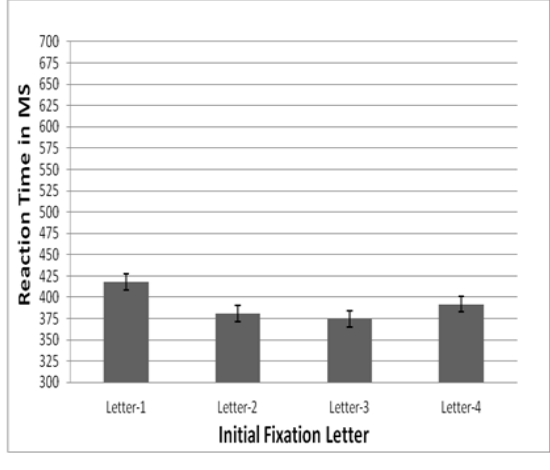
Figure 3. Reaction time for four-letter words as a function of the initial fixation letter (first, second, third, and fourth letter). Note: Error bars represent stan- dard